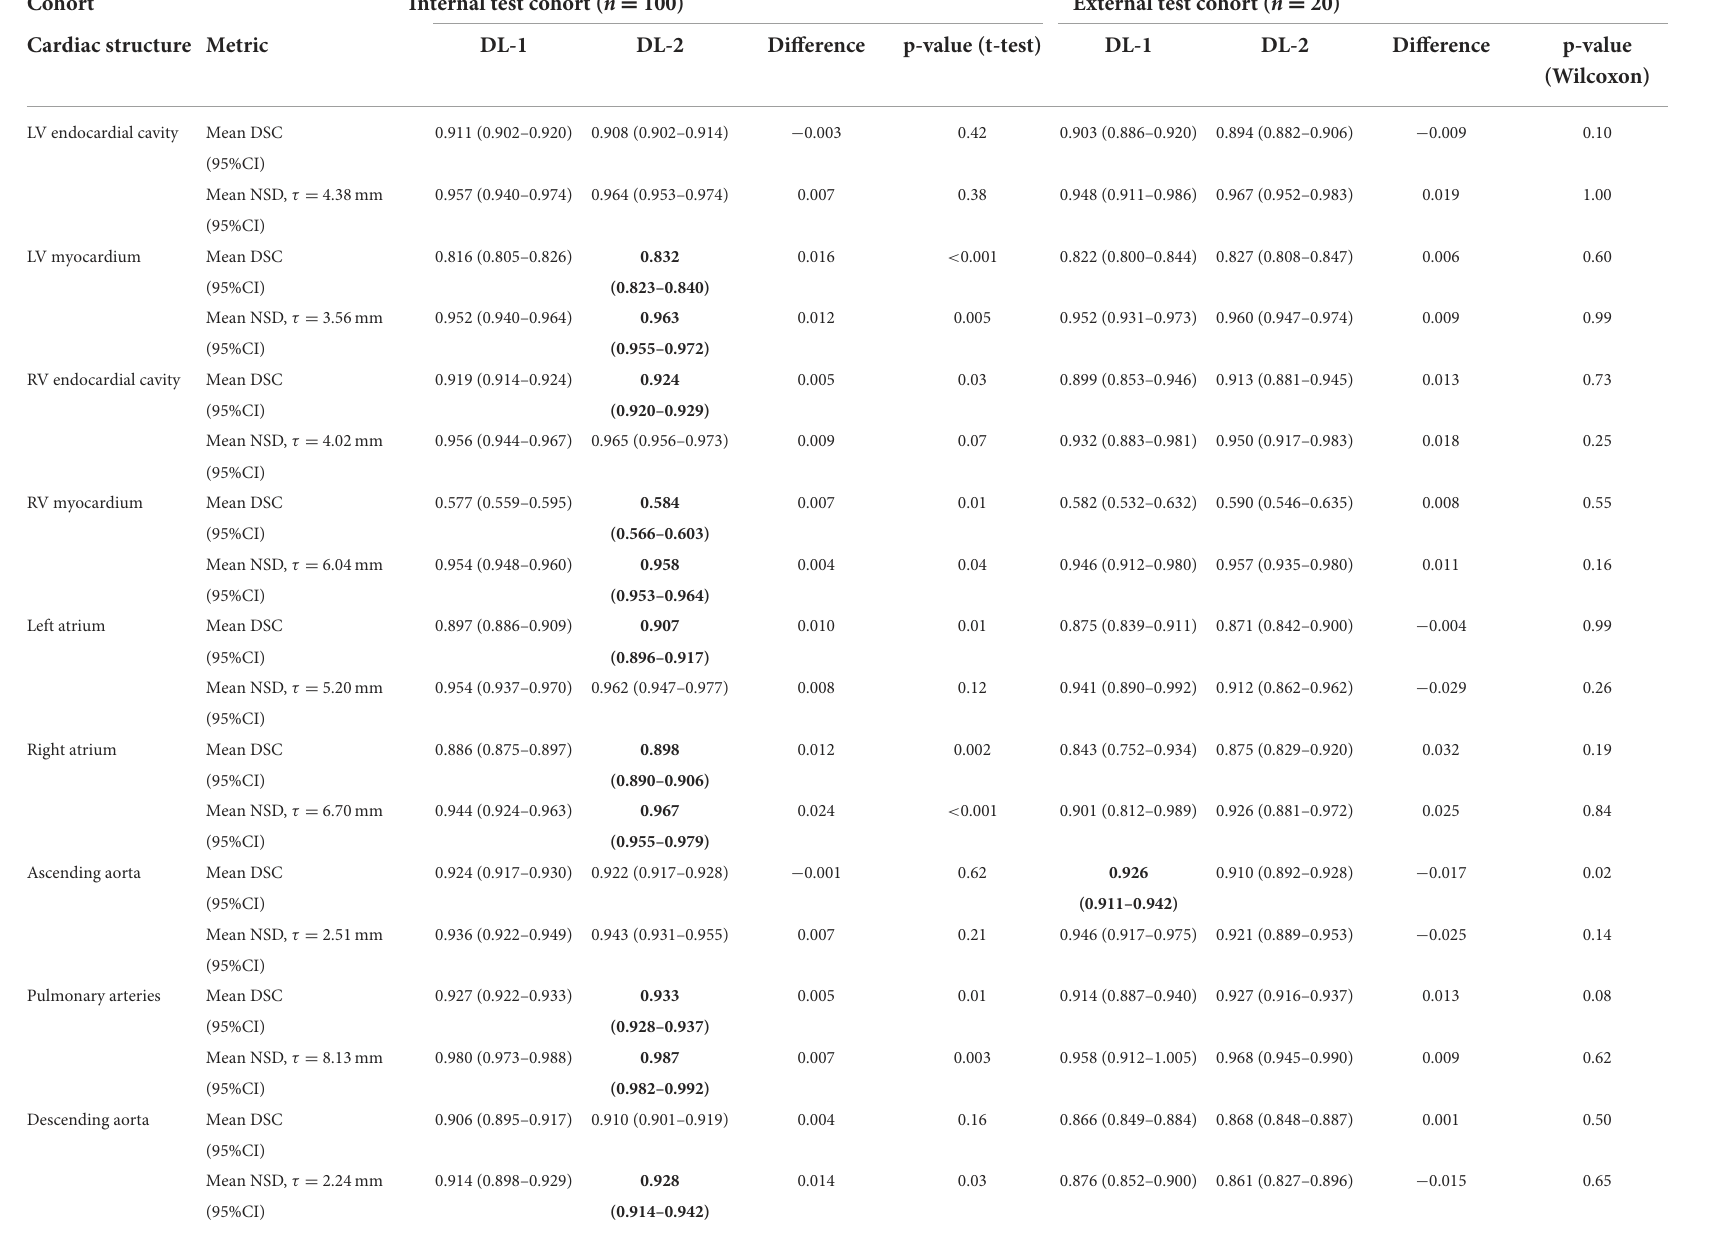
TABLE 4 Dice similarity coefficients (DSC) and normalised surface distances (NSD) in the internal and external test cohorts for DL model 1 (DL-1) and DL model 2 (DL-2)